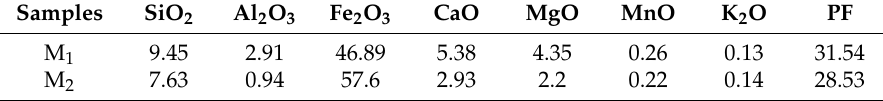
Table 1. Chemical composition (percent oxides, X-ray fluorescence) of the two raw materials.